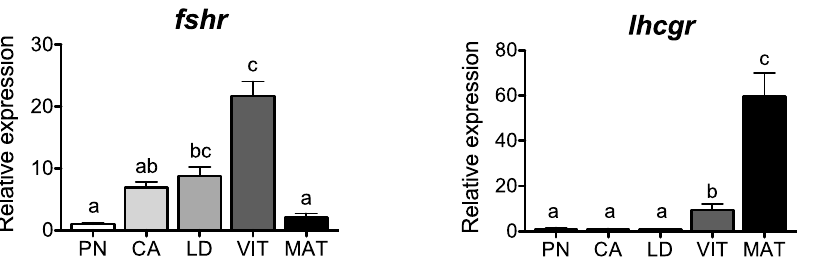
Fig. 1. Expression profiles of gonadotropin hormone receptor genes during major stages of oogenesis in coho salmon. Messenger RNA levels were analyzed by qPCR and data were normalized to the geometric mean of four reference genes ( eef1a , ctsd , ctsz and actb ). PN, perinucleolus stage follicles; CA, cortical alveolus stage follicles; LD, lipid droplet stage follicles; VIT, mid-vitellogenic stage follicles; MAT, postvitellogenic/preovulatory stage follicles. Bars not sharing the same letter are significantly different (P , 0.05; n 5 4 fish/stage for PN-, CA-, LD-, and VIT-stages, n 5 3 fish for MAT-stage, mean ¡ SEM).